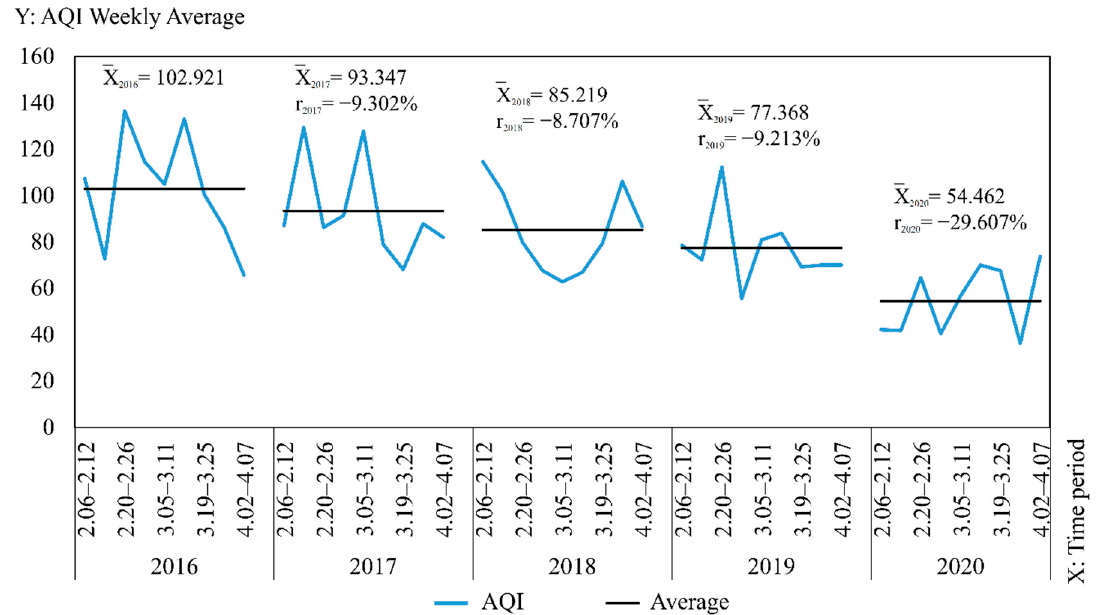
Figure 5. AQI weekly average year-on-year change folding chart from 2016 to 2020.